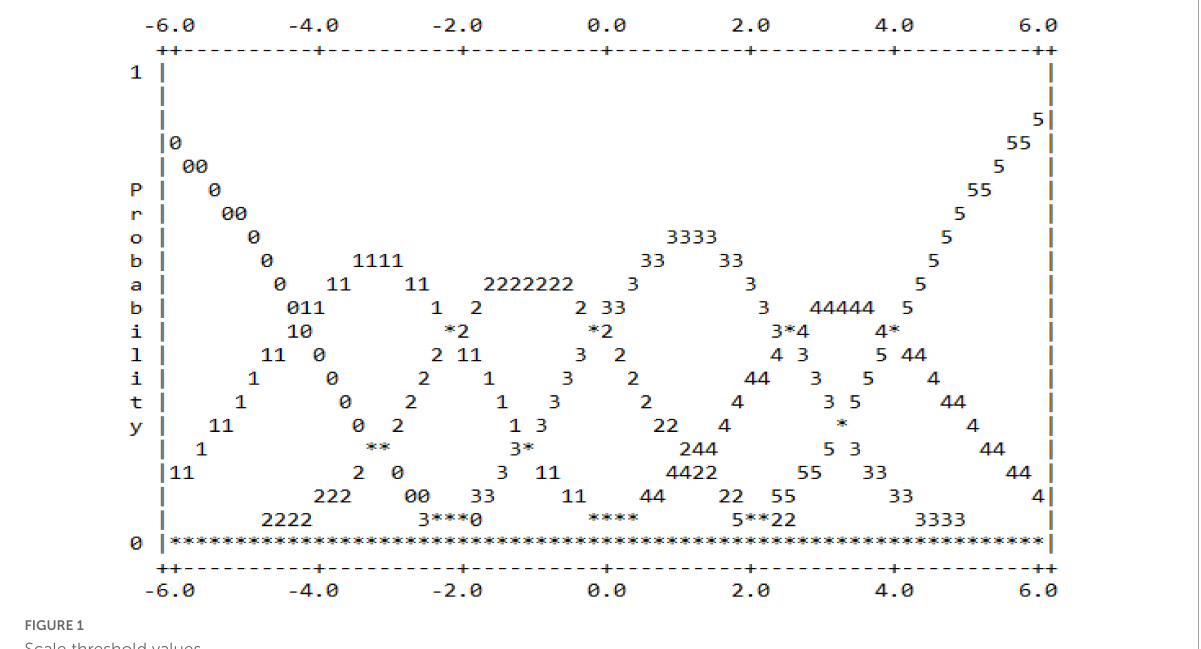
FIGURE1 Scale threshold